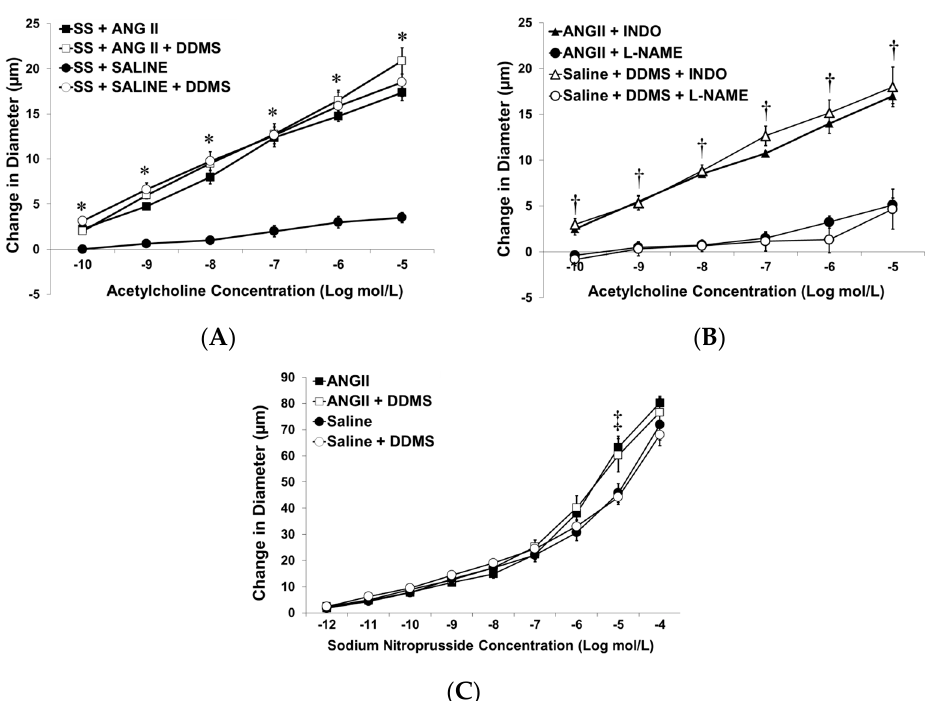
Figure 2. Response of isolated middle cerebral arteries of SS rats fed high-salt diet and receiving infusion of either isotonic saline or angiotensin II (ANG II; 100 ng/kg/min) from an osmotic minipump to: ( A ) acetylcholine (ACh; 10 − 10 –10 − 5 M) ± acute addition of DDMS (50 µ M); ( B ); ACh ± DDMS (50 µ M) and/or ± L-NAME (100 µ M) or indomethacin (INDO; 1 µ M); and ( C ) sodium nitroprusside (10 − 12 –10 − 4 M) ± acute addition of DDMS (50 µ M) to the tissue bath. Data are expressed as mean change in diameter ( µ m) from baseline ± SEM, and n = 6–8 for all groups. Significant difference: * p < 0.05 vs. saline-infused SS rats, † p < 0.05 vs. L-NAME-treated vessels, ‡ p < 0.05 vs. saline-infused SS ± DDMS at the 10 − 5 M dose.